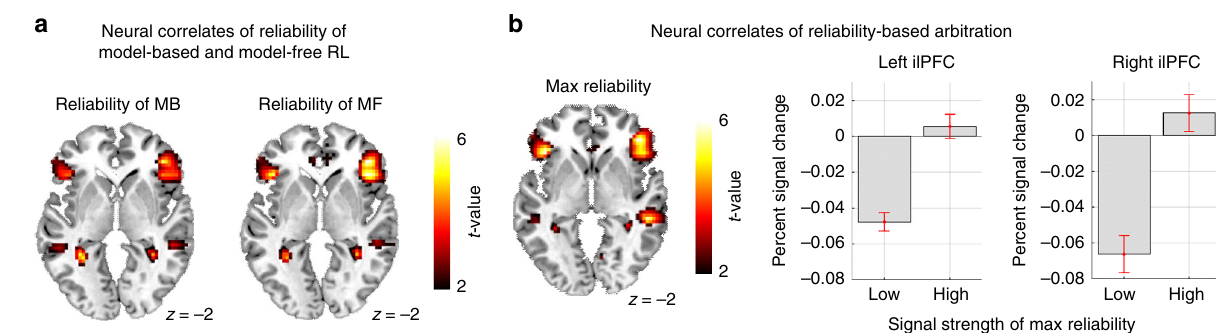
Fig. 7 Neural signatures of model-free and model-based RL and arbitration control. a Bilateral ilPFC encodes reliability signals for both the MB and the MF systems. Note that the two signals are not highly correlated (absolute mean correlation <0.3); this task design was previously shown to successfully dissociate the two types of RL 30 . Threshold is set at p < 0.005. b (Left) Inferior lateral prefrontal cortex bilaterally encodes reliability information on each trial of both MB and MF RL, as well as whichever strategy that provides more accurate predictions ( “ max reliability ” 30 ). (Right) The mean percent signal change for a parametric modulator encoding a max reliability signal in the inferior lateral prefrontal cortex (lPFC). The signal has been split into two equal- sized bins according to the 50th and 100th percentile. The error bars are SEM across subjects.